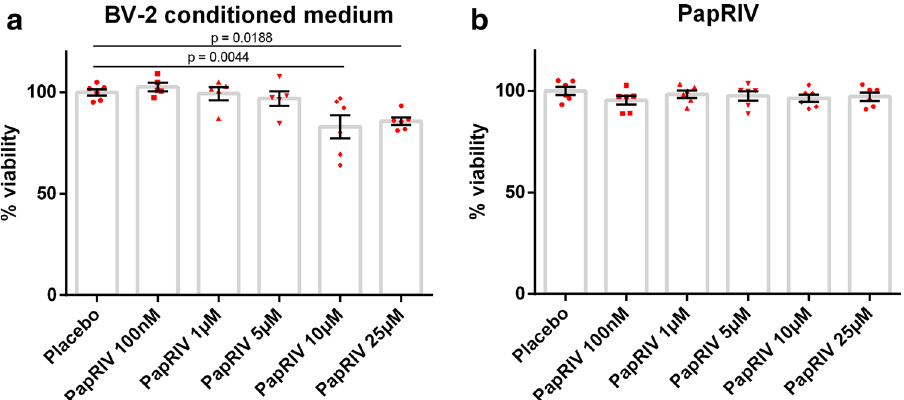
Figure 3. Indirect neurotoxic effects of PapRIV via microglia activation. ( a ) Treatment of SH-SY5Y cells with conditioned medium of PapRIV peptide-treated BV-2 cells is toxic for these neuroblasts (n = 6). ( b ) Direct treatment of SH-SY5Y cells with PapRIV shows no direct toxicity (n = 6). Mean ± SEM, one-way ANOVA, post- hoc Dunnett.